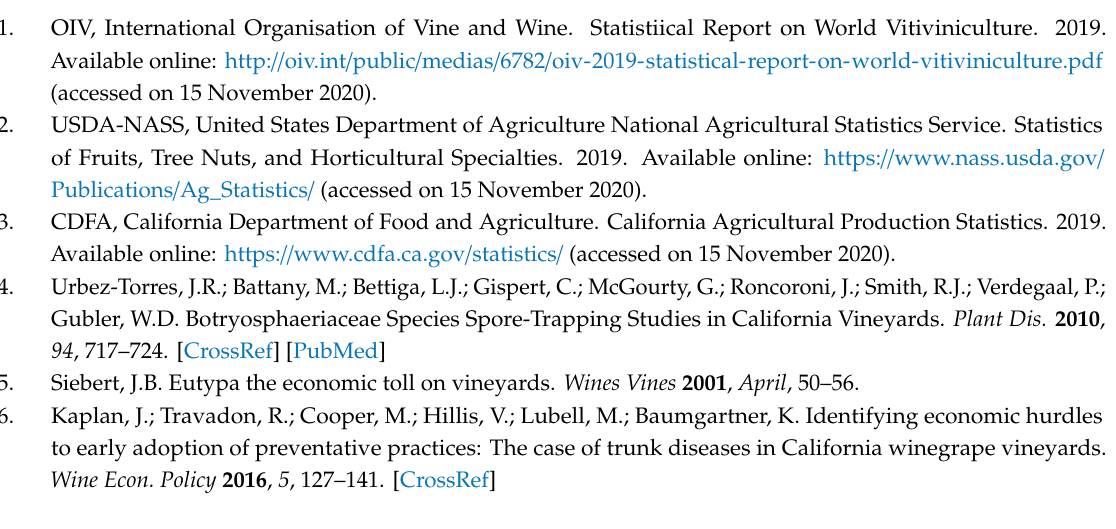
Figure S1: Fitted Regression Lines for replanting field trial results; Figure S2: Projected yield (kg / vine) by vineyard age for the untreated control, treatment 1 (75% disease control e ffi cacy) and treatment 2 (50% disease control e ffi cacy); Figure S3: Change in Net Returns per hectare over the 25 year vineyard lifespan for treatment 1 (75% disease control e ffi cacy) and treatment 2 (50% disease control e ffi cacy), Table S1: Data and Sources for Vine Replacement Cost, Mature Yield and Grape Prices; Table S2: Predicted Avoided Losses due to treating vines with pruning wound protectant per hectare over first 12 years of vineyard